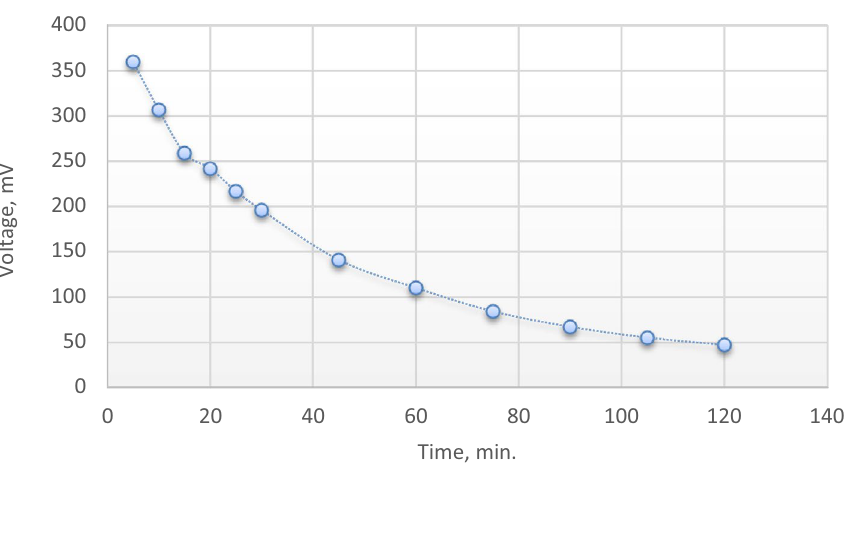
Fig. 5 Voltage change over time of a 4-cell battery with 22Ω load applied